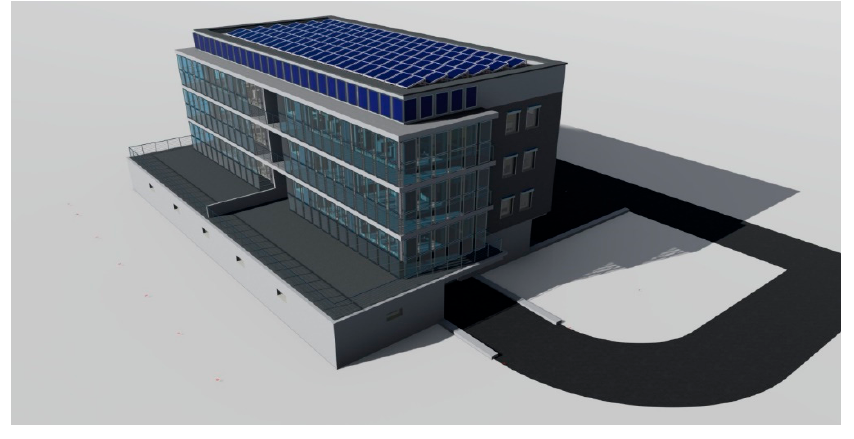
Figure 10. Model 3 of the building.